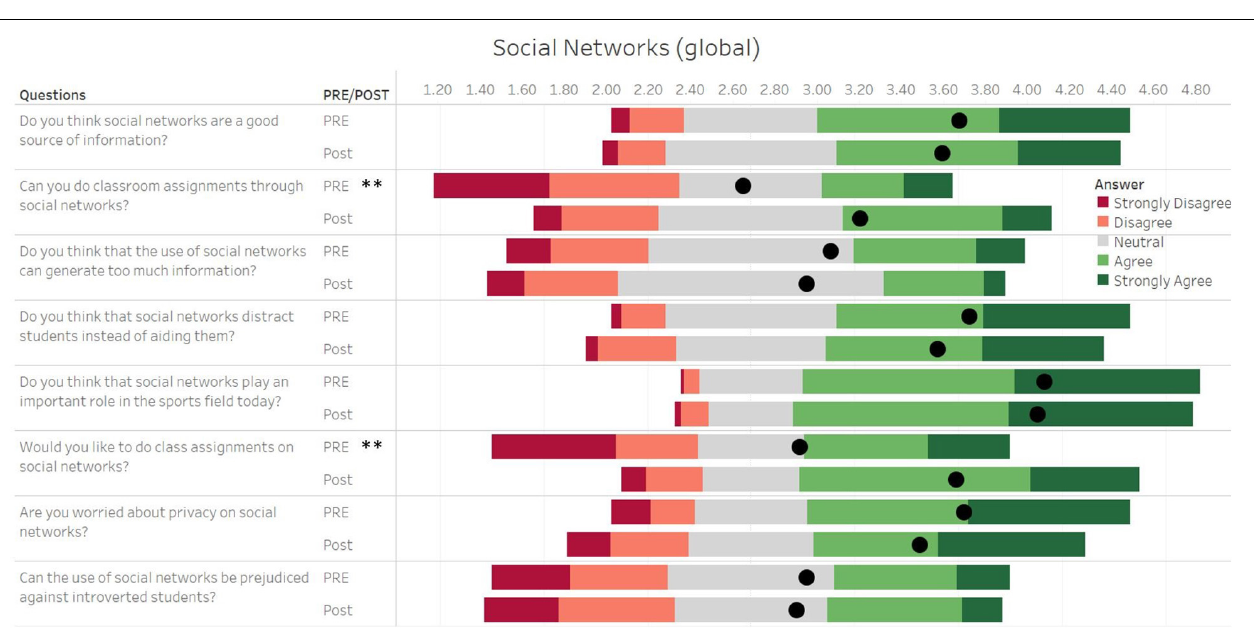
non-significant (PRE: 2.52 ± 1.38 vs POST: 2.73 ± 1.18; p =